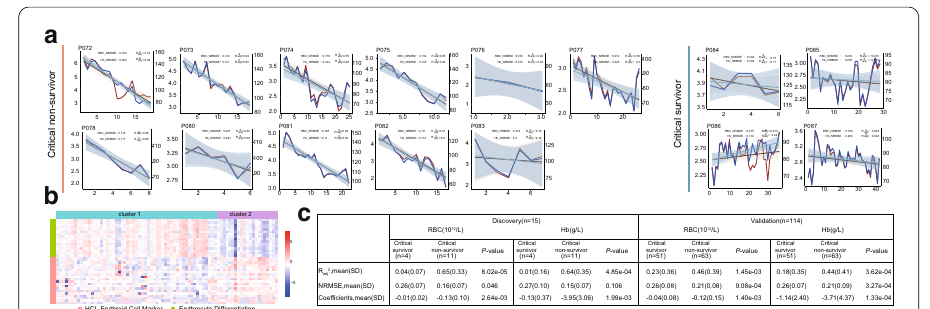
Fig. 3 The dynamic changes of RBC and Hb levels in critically ill COVID-19 patients with different outcome. a Red blood cell (RBC) count and hemoglobin (Hb) of critical(survival) and critical(death) patients. The red and blue lines represent the RBC and Hb levels, respectively. Normalized root means square error (NRMSE) and R adj2 are marked at the top right. b The heatmap of erythrocyte differentiation genes and HCL-erythroid cell marker genes in Cluster 1 and Cluster 2. c The RBC and Hb characteristics of COVID-19 patients in discovery and validation